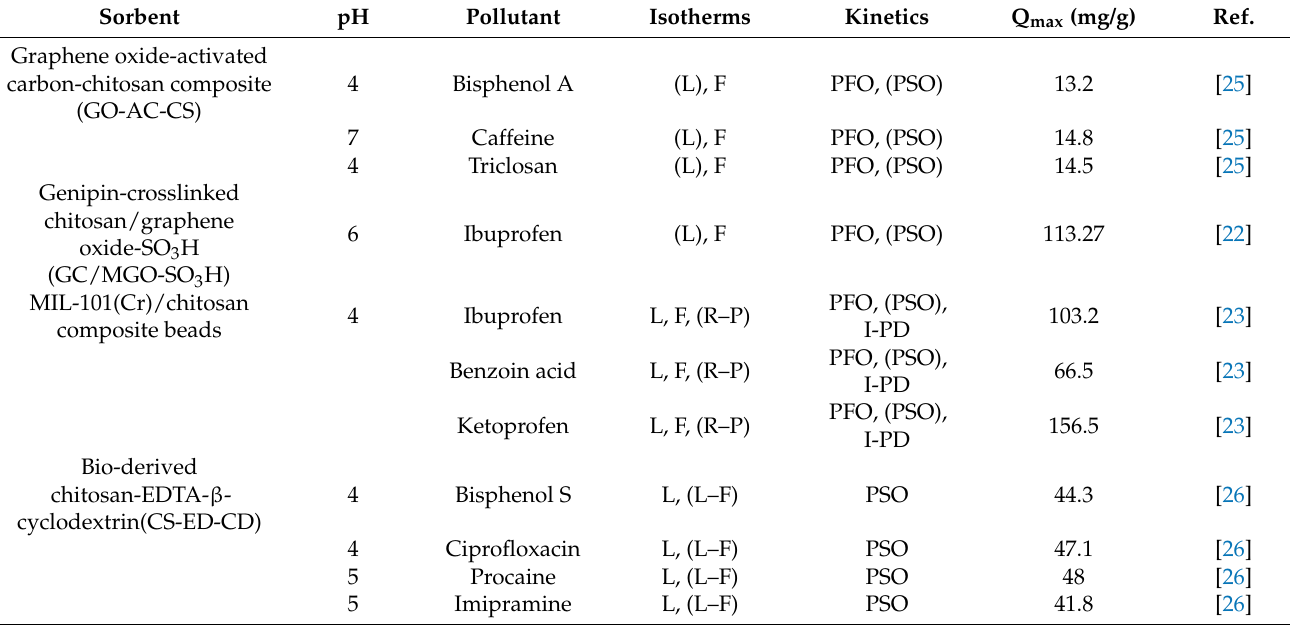
Table 2. Selected studies for the adsorption of personal care products from aqueous solutions, at 25 ◦ C using modified chitosan adsorbents. The optimum mathematical fitting of isotherm and kinetic models, derived from the experimental results after the adsorption process, are abbreviated with